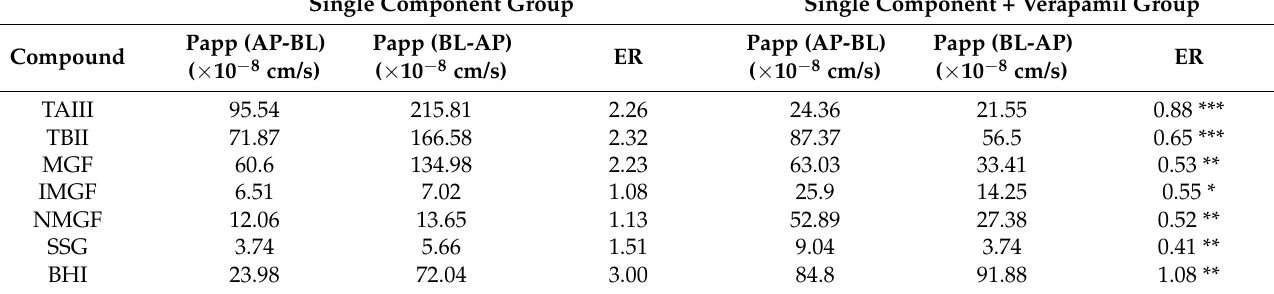
Table 1. Effect of verapamil on the ER and Papp of timosaponin A III (TAIII), timosaponin B II (TBII), mangiferin (MGF), neomangiferin (NMGF), isomangiferin (IMGF), sarsasapogenin (SSG), and baohuoside I (BHI). (n =